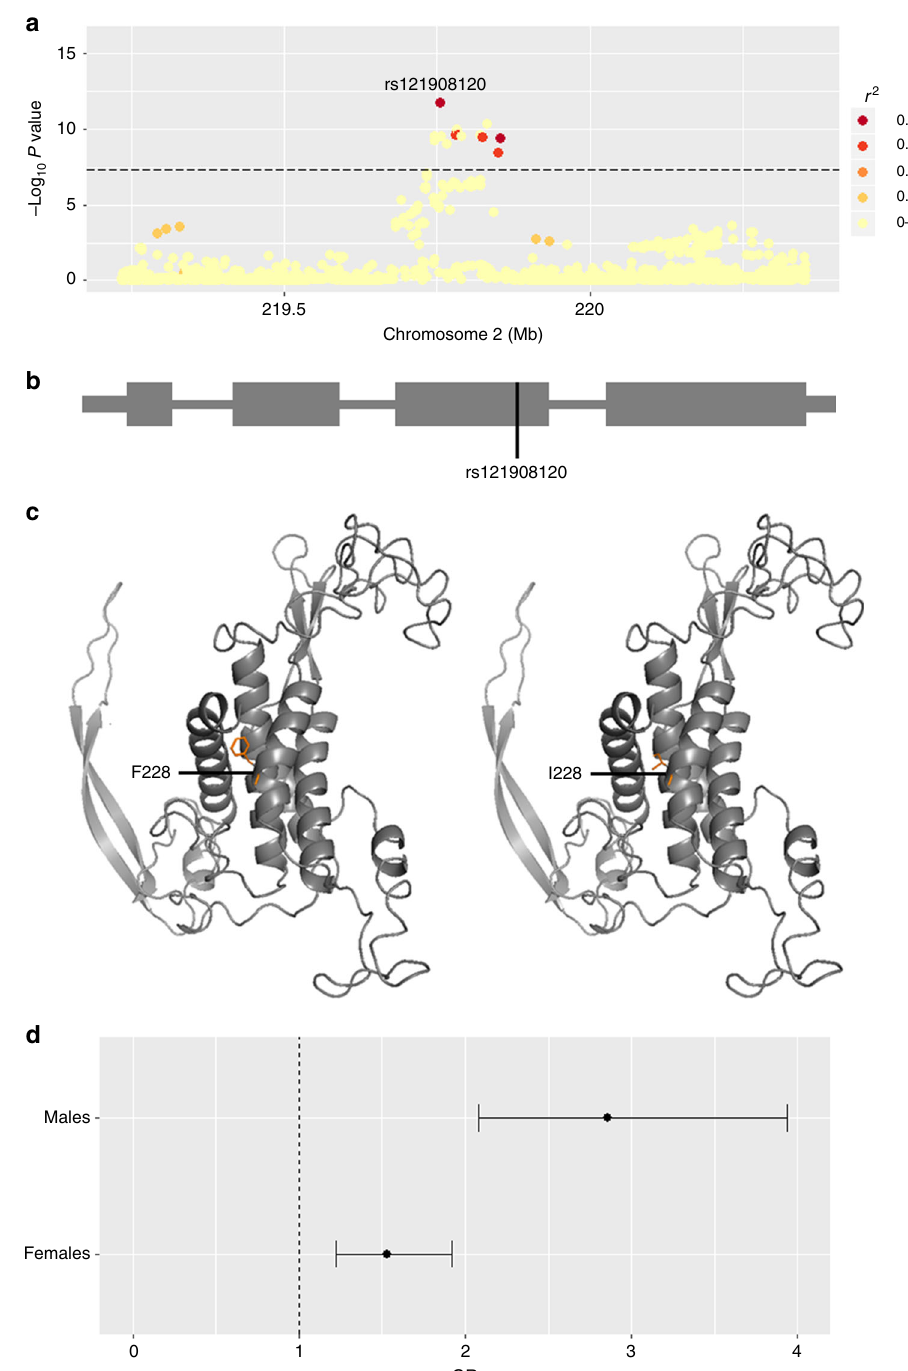
Fig. 1 Acne association at the 2q35 locus ( WNT10A ). a Regional acne association plot, variants coloured according to the degree of LD ( r 2 ) with the lead SNP (rs121908120, WNT10A :p.F228I). b Location of the rs121908120, p.F228I with respect to the WNT10A gene structure. c Partial three dimensional predicted protein structure incorporating phenylalanine (risk, left) or isoleucine (protective, right) at position 228 (SWISS-MODEL repository). d Forest plot indicating the difference in the effect size of the acne association between males and females for rs121908120. Error bars represent 95% con fi dence intervals for estimated odds FST (5q11.2) have been identi fi ed as mediators of the morpho- logical changes that occur through the hair follicle cycle 20,21 .